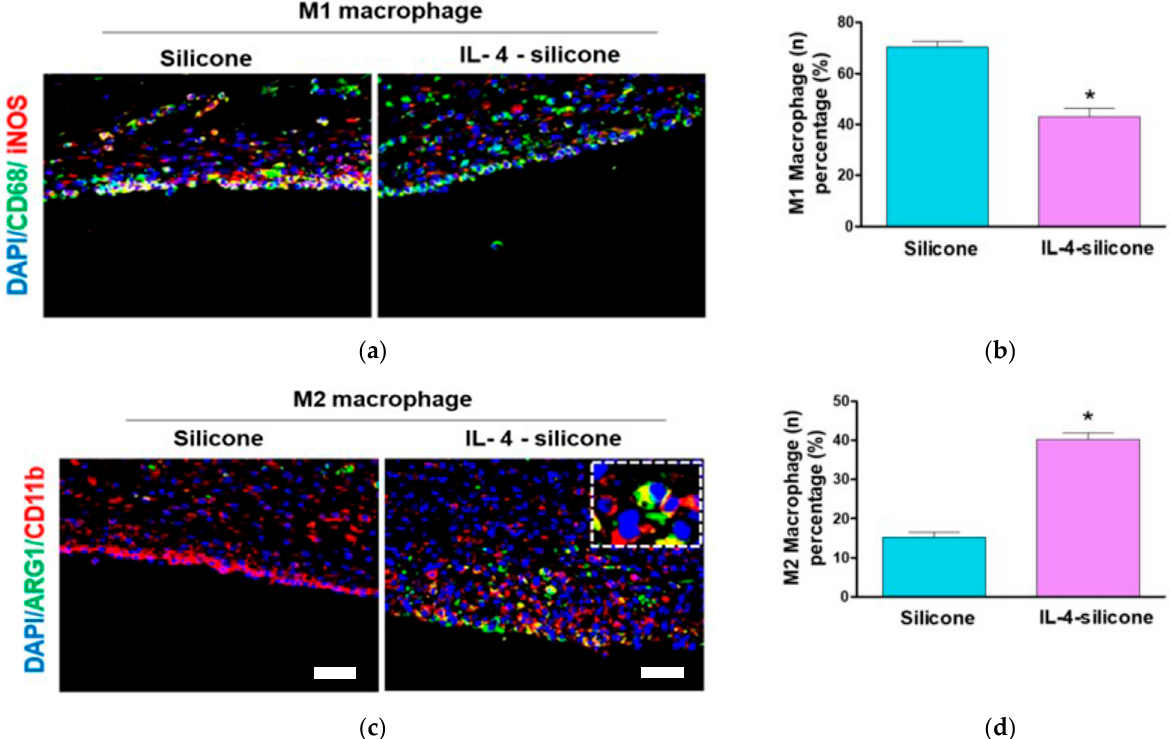
Figure 5. The effect of IL-4-coated silicone implants on macrophage polarization in vivo. ( a ) Representative CLSM images of tissues. Green fluorescence indicates CD68-positive macrophages. Red fluorescence indicates iNOS-positive macrophages. ( b ) Quantification of M1 macrophages. ( c ) Representative CLSM images of tissues. Green fluorescence indicates ARG-1-positive macrophages. Red fluorescence indicates CD11b-positive macrophages. ( d ) Quantification of M2 macrophages. Scale bars represent 50 μ m. The data represent means ± SEMs, five animals per group. * Significantly ( p < 0.05; t -test) different from the bare silicone implant group.